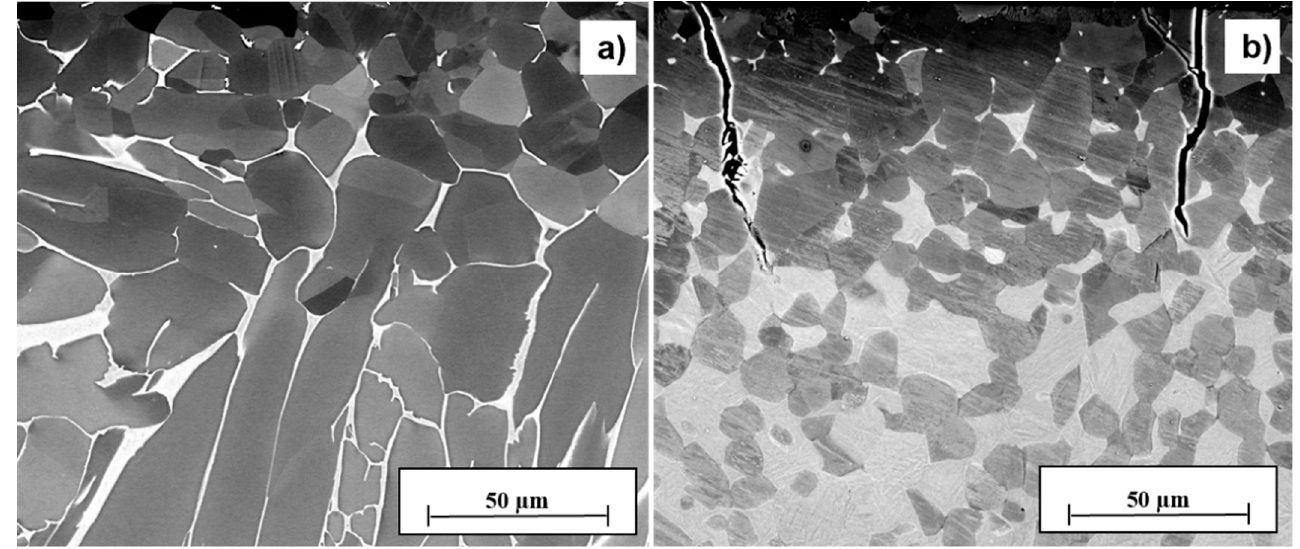
Figure 2. Exemplary micrographs of the near-surface area of Ti-6Al-4V samples after solution treatment A ( a ) and B ( b ), hydrogenated at 500 °C for 2 h.